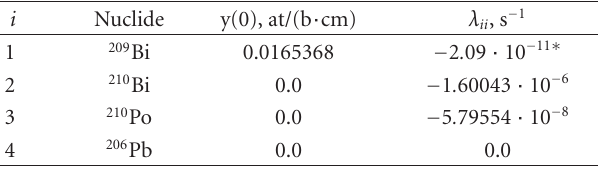
Table 1: Input parameters for calculation of 210 Po